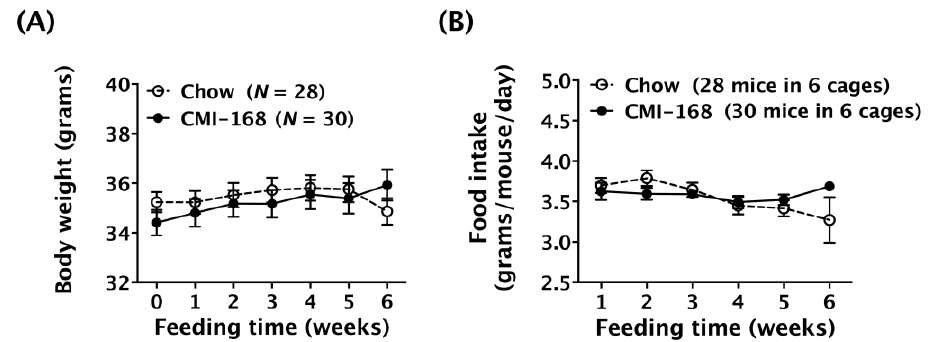
Figure 1. Effects of six-week Chicken Meat Ingredient (CMI-168) supplementation on the gain in body weight and food intake in mice. (A) Body weight of mice on the Chow- and CMI-168-supplemented diets over the experimental period. (B) Food intake of mice on the Chow- and CMI-168-supplemented diets over the experimental period.